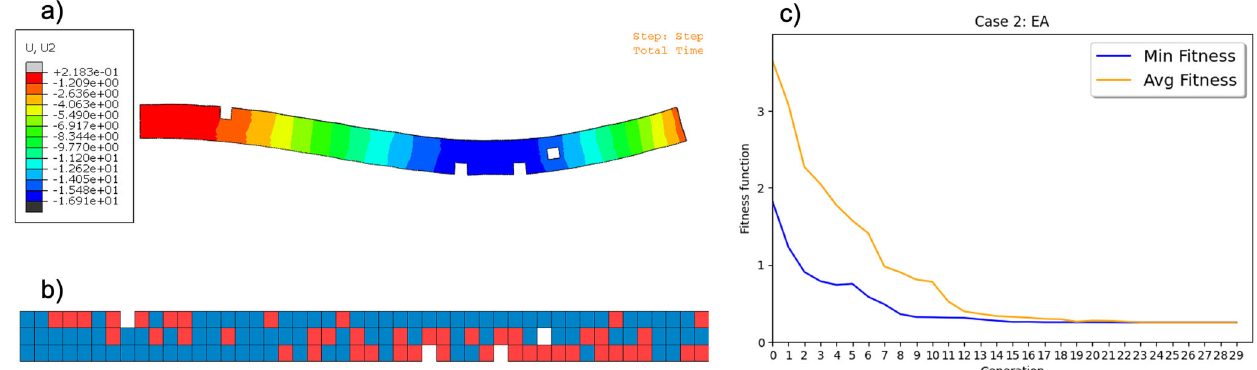
Fig. 10 The results for the second case study. ( a ) the displacement of the optimal solution, ( b ) the optimal material distribution generated by the EA, and ( c ) convergence statistics for the evolutionary